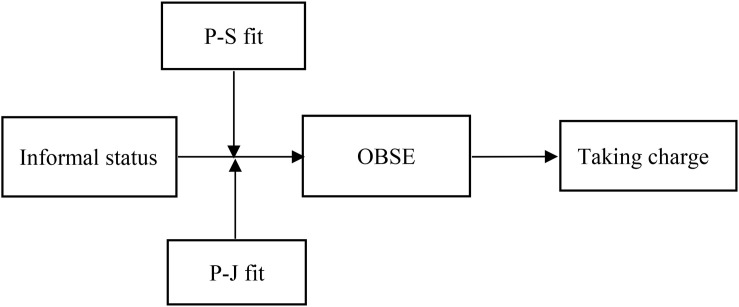
Research framework.